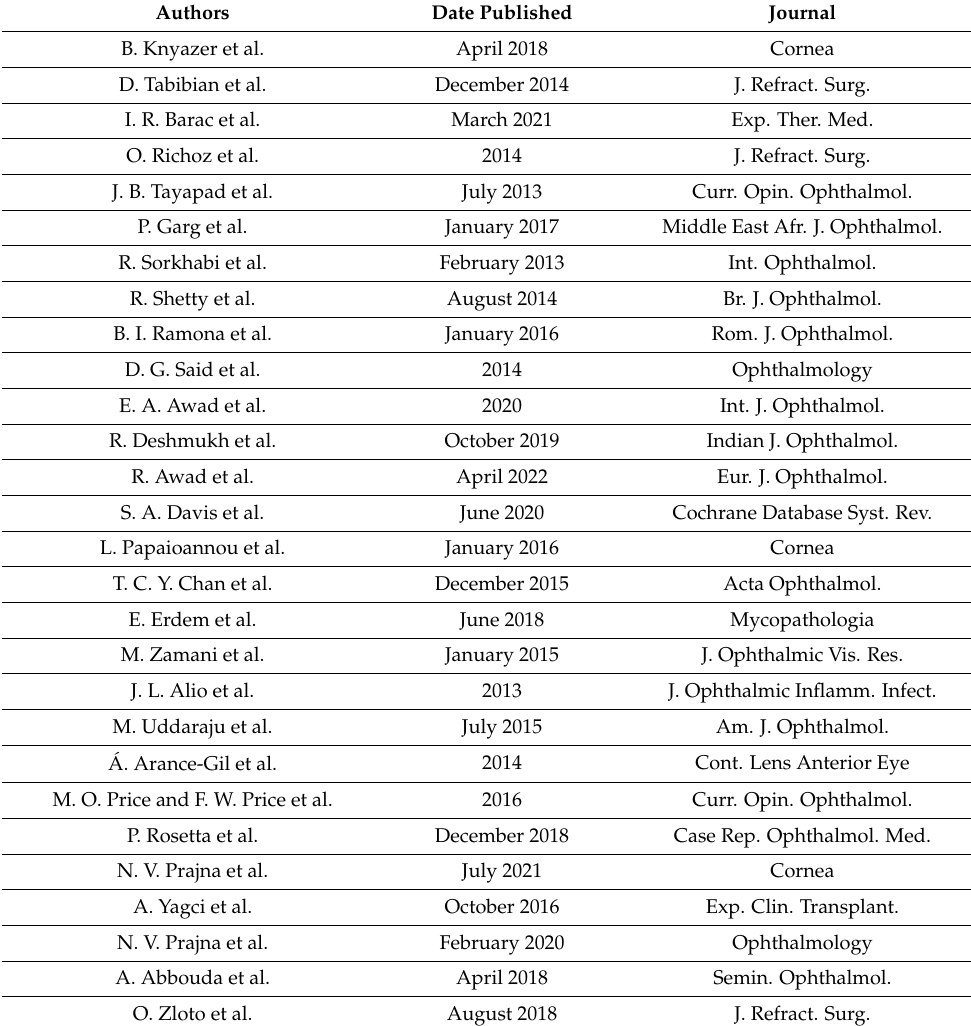
Table A1. Complete list of papers included in the